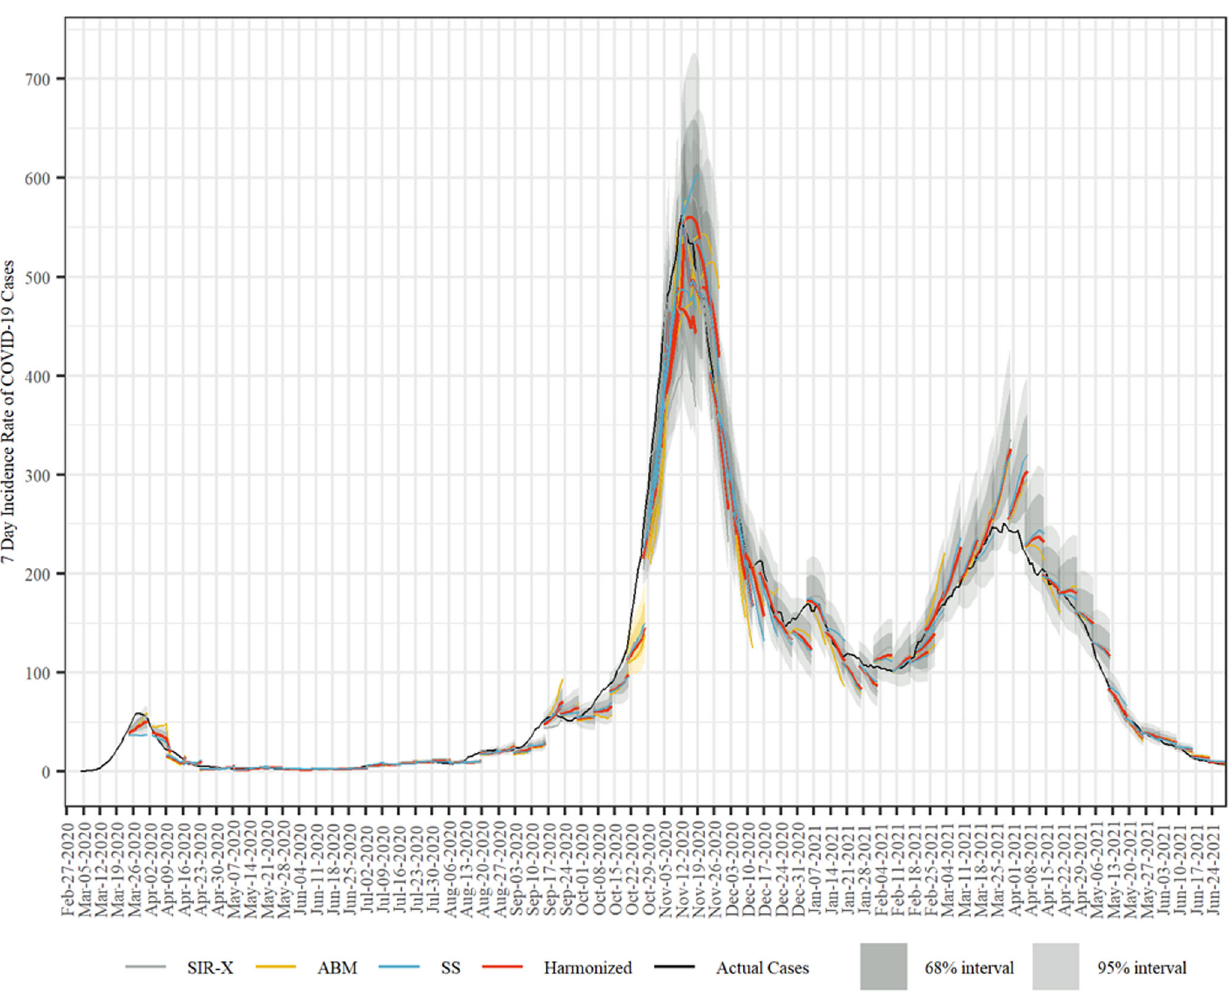
Fig. 1 Rolling combined and consolidated out-of-sample forecasts for the 7 day incidence rate of con fi rmed cases in Austria. We show the weekly predictions from the three different models, their arithmetic average with it corresponding CI, and the actual case numbers. The underlying data is found in Supplementary Data